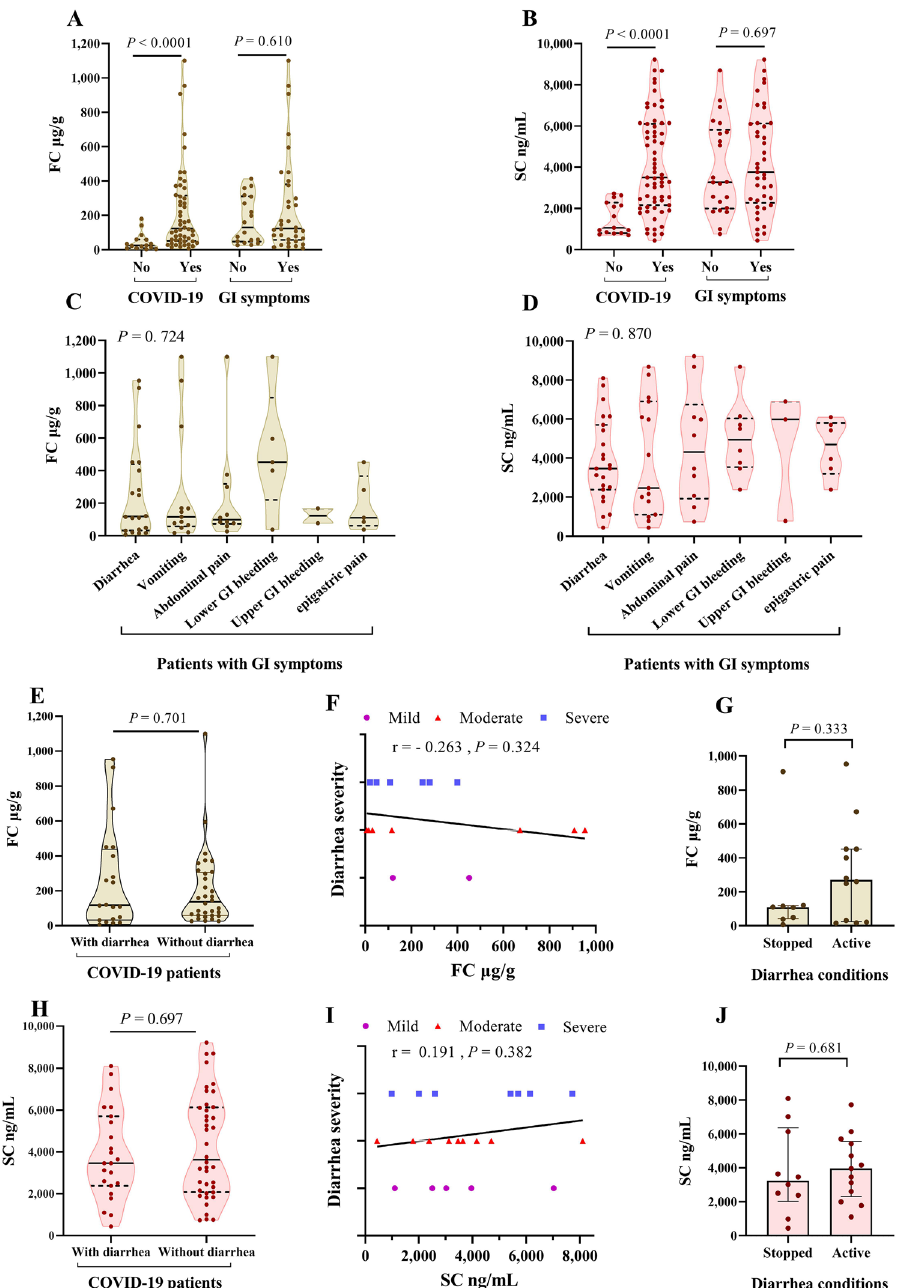
Figure 3. Concentrations of SC and FC in COVID-19 and healthy donors. Comparison of FC and SC concentrations based on COVID-19 infection as well as having GI symptoms ( A , B ). SC and FC levels based on the types of GI problems in patients with GI symptoms ( C , D ). SC and FC concentrations in COVID-19 patients based on the presence of diarrhea ( E , H ). The correlation of FC and SC with diarrhea severity ( F , I ). Comparison of FC and SC levels between two diarrhea conditions ( G , J ). Plots show median ± interquartile range, and P values are shown in the